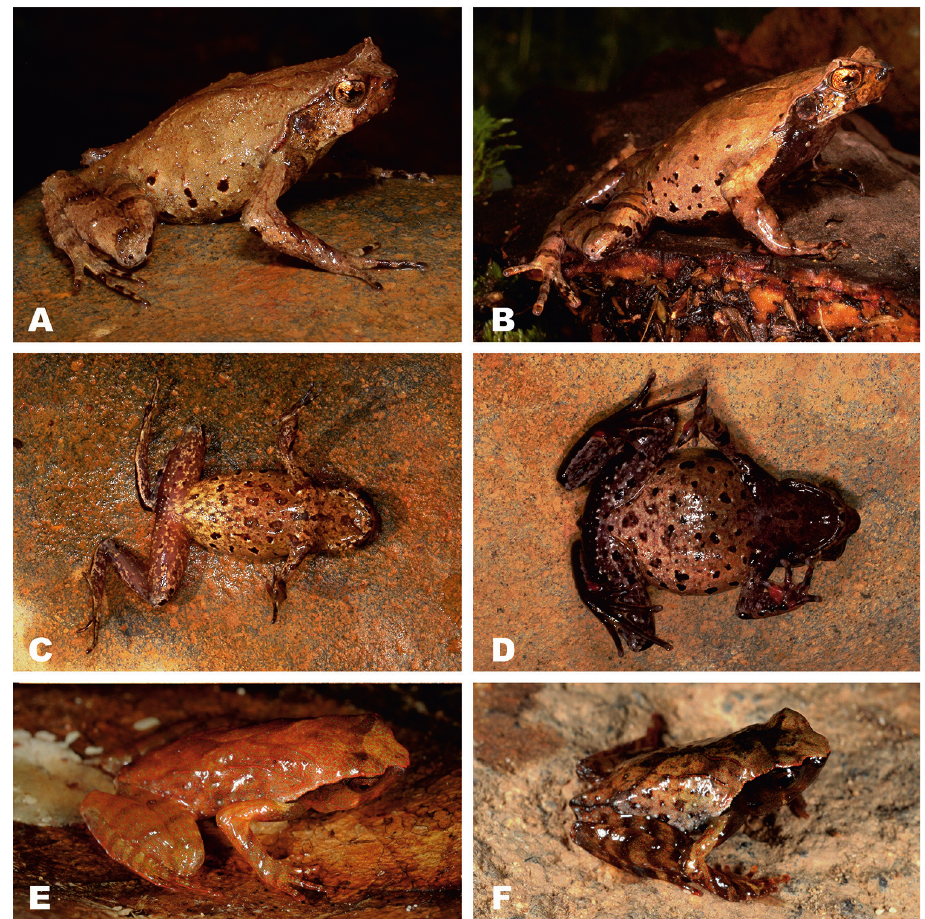
Figure 10. Paratypes of Ophryophryne elfina sp. n. in life. A–D Bidoup Mt., Bidoup–Nui Ba N.P., Lam Dong Prov., 2000 m a.s.l.: A ZMMU A-4788 (field number NAP-01449), male, dorsolateral view B ZMMU A-4788 (field number NAP-01455), female, dorsolateral view C ZMMU A-4788 (field num- ber NAP-01449), male, ventral view D ZMMU A-4788 (field number NAP-01455), female, ventral view E–F Chu Yang Sin Mt., Chu Yang Sin N.P., Dak Lak Prov., 1800 m a.s.l.: E ZMMU A-5691 (field number ABV-00580), metamorph, dorsolateral view F ZMMU A-5691 (field number ABV-00581), metamorph, dorsolateral view. Photos by N.A.